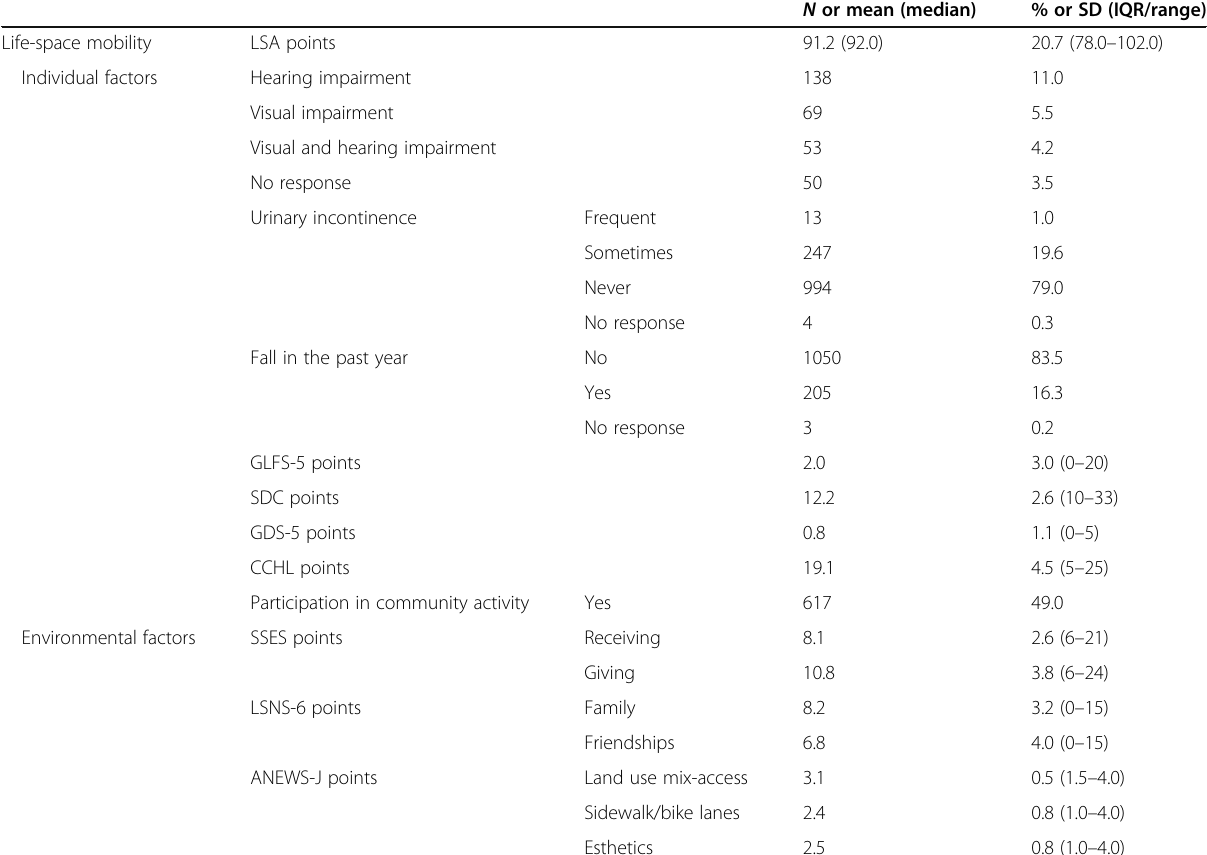
Table 2 LSA and individual and environmental characteristics of study participants ( n = 1258) Life-space